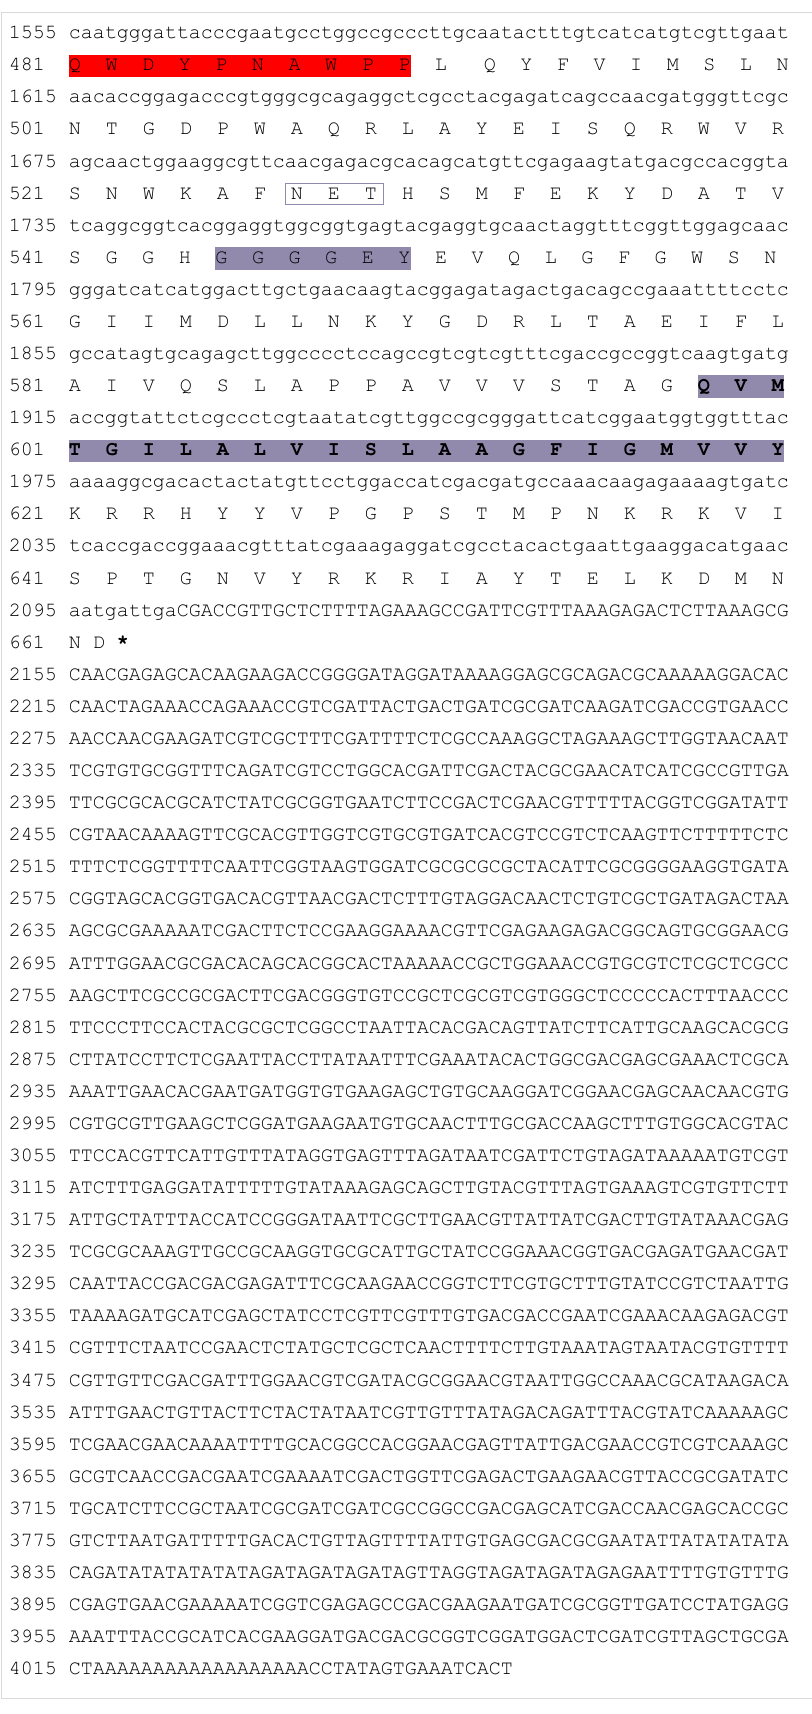
Fig 1 . Nucleotide and deduced amino acid sequences of BlTre-2 .